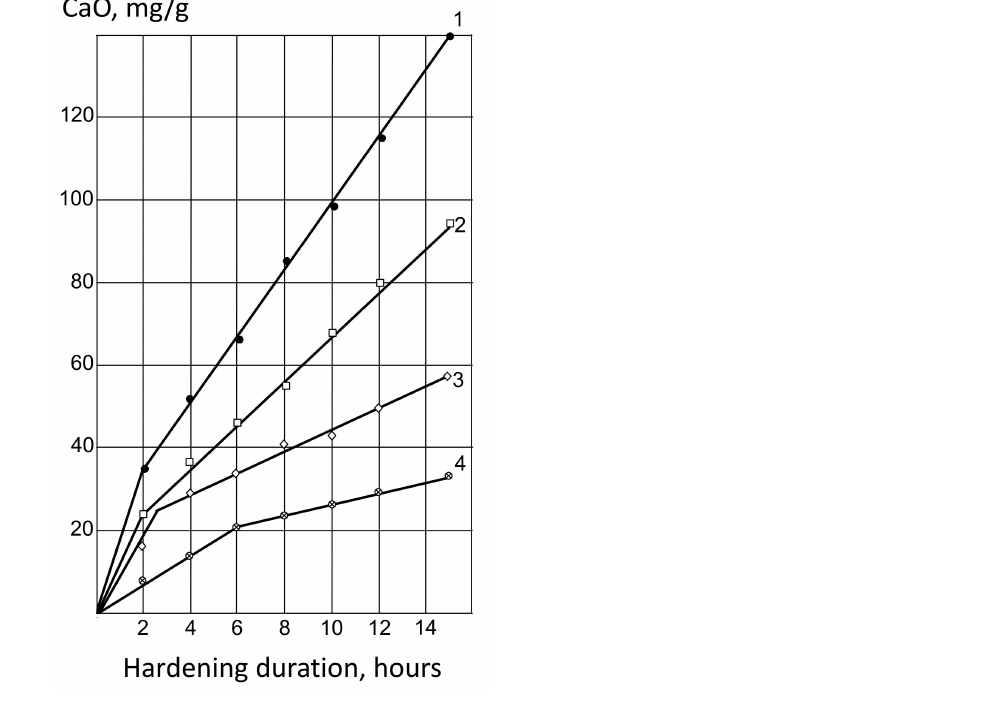
Figure 2. Kinetics of CaO by active admixture absorption: 1—MK; 2—MK—50%, A—50%; 3—MK–20%, A—80%;